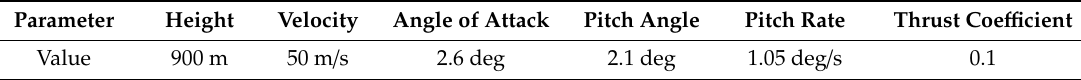
Table 1. Initial flight conditions of method validation.